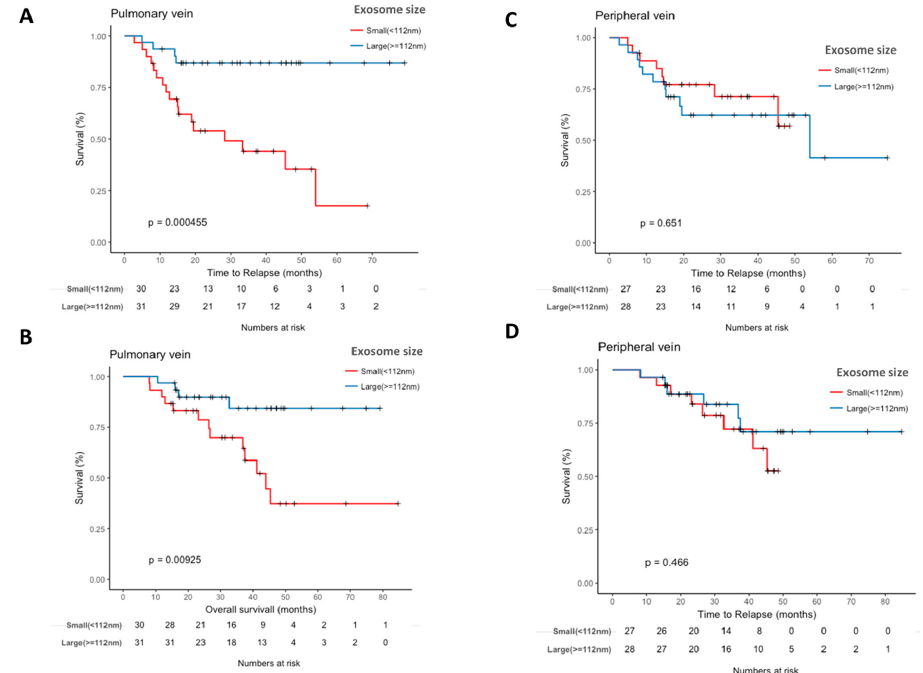
Figure 3. Kaplan-Meier survival analysis of associations between exosomal size and time to relapse (TTR) and overall survival (OS) among patients with NSCLC. ( A ) TTR according to pulmonary vein exosomal size. ( B ) OS according to pulmonary vein exosomal size. ( C ) TTR according to peripheral vein exosomal size. ( D ) OS according to peripheral vein exosomal size.